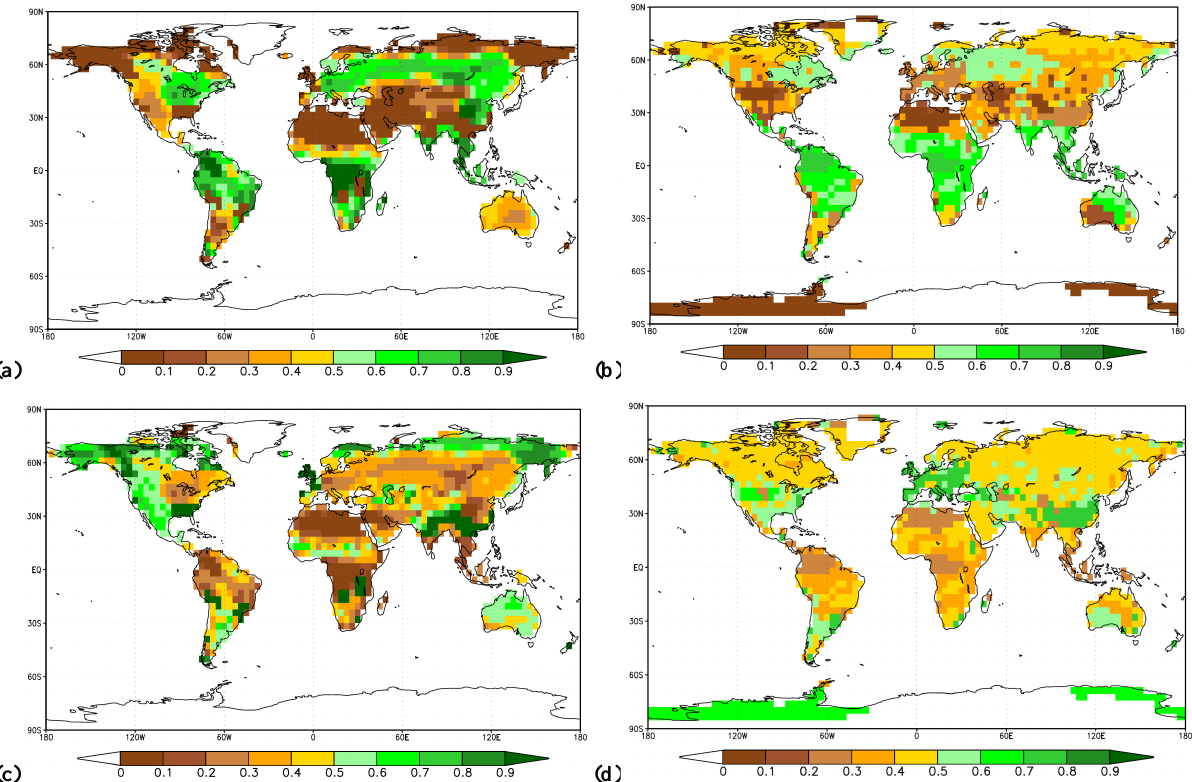
Fig. 5. Vegetation forcing for PI control and Pliocene: Forest fractions for PI (a) and mid-Pliocene (b) , grass fractions for PI (c) and mid- Pliocene (d) . See text for details. Fig. 7. Vegetation forcing for PI control and Pliocene: Forest fractions for PI (a) and mid-Pliocene (b) , grass Fig. 7. Vegetation forcing for PI control and Pliocene: Forest fractions for PI (a) and mid-Pliocene (b) , grass fractions for PI (c) and mid-Pliocene (d) . See text for details. fractions for PI (c) and mid-Pliocene (d) . See text for details. Fig. 7. Vegetation forcing for PI control and Pliocene: Forest fractions for PI (a) and mid-Pliocene (b) , grass Fig. 7. Vegetation forcing for PI control and Pliocene: Forest fractions for PI (a) and mid-Pliocene (b) , grass fractions for PI (c) and mid-Pliocene (d) . See text for details. fractions for PI (c) and mid-Pliocene (d) . See text for details.